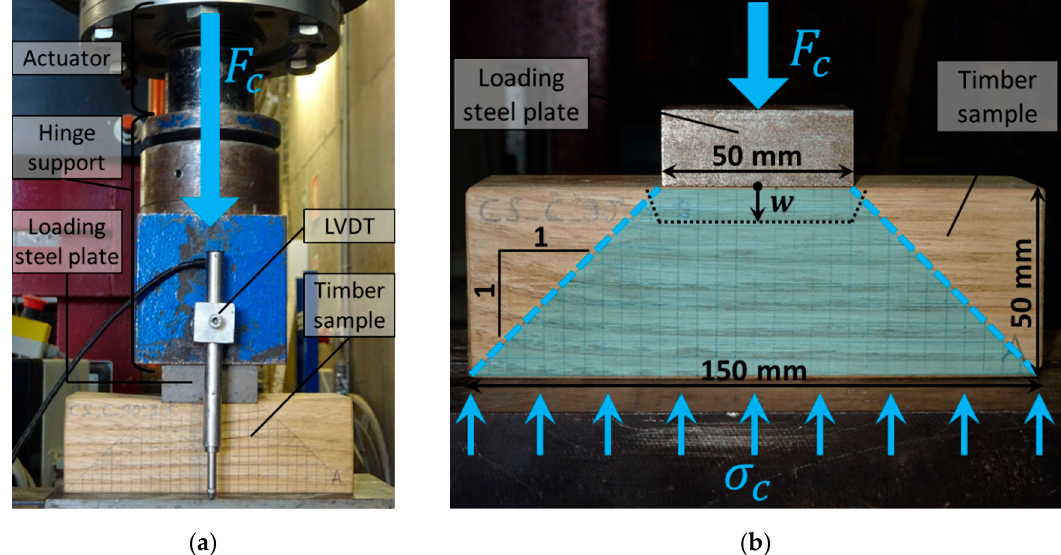
Figure 3. Compressive stress–strain curve perpendicular to the grain of wood, including the respective strength 𝑓 (cid:3030),(cid:2877)(cid:2868) and elastic modulus 𝐸 (cid:3030),(cid:2877)(cid:2868) . Scheme inspired from [21,22].